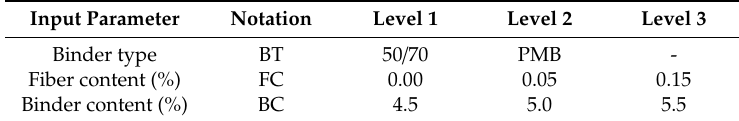
Table 1. Input parameters and their corresponding levels.